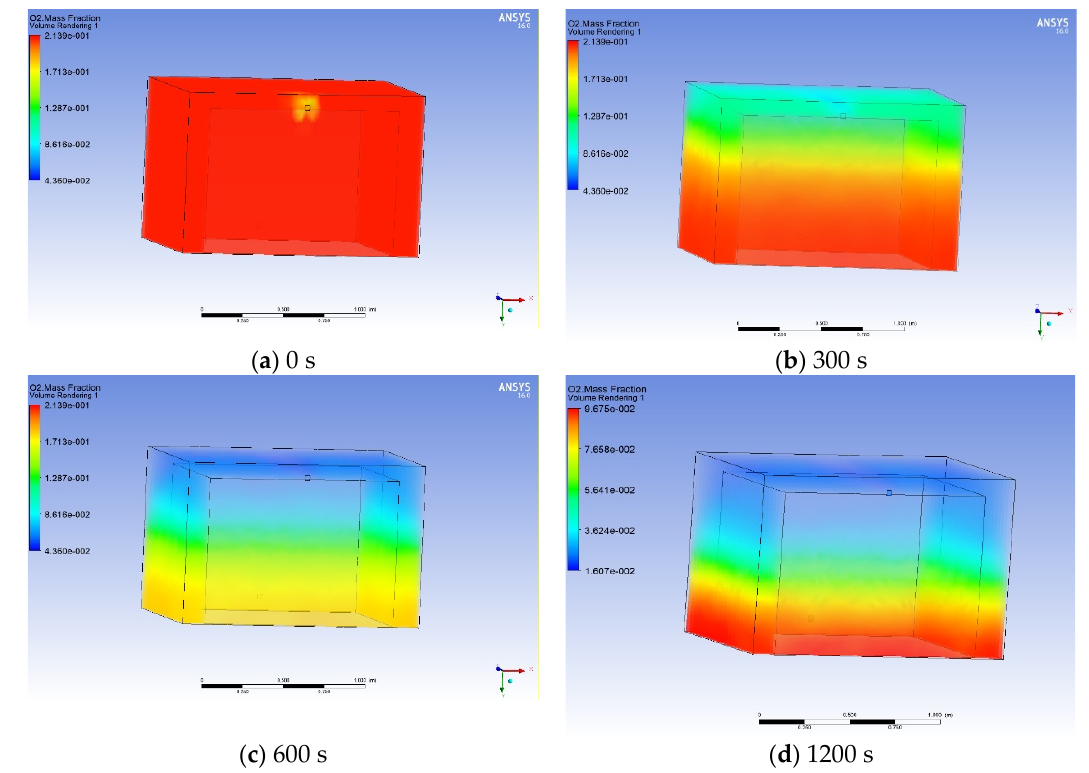
Figure 4. Distribution of oxygen (O 2 ): This figure describes the distribution of O 2 at different time points when nitrogen (N 2 ) is introduced into the air-conditioning box. The color corresponds to the density bar on the left side of the image. The figure, in turn, corresponds to the O 2 distribution at 0 s, 300 s, 600 s, and 1200 s.